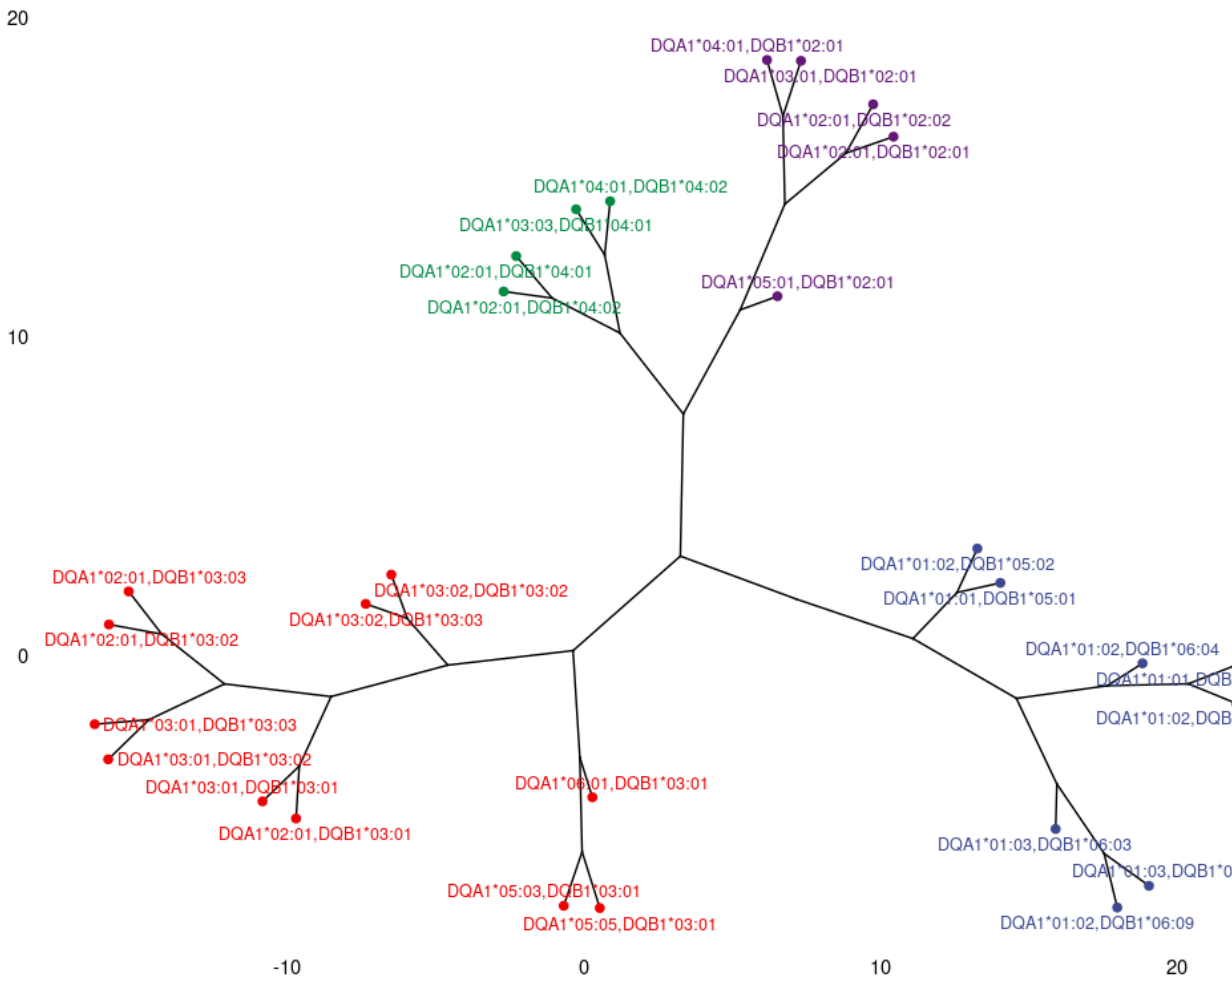
Figure 4. Dendrogram representing anti-HLA-DQ response correlations based on Minkowski dis- tances of antigen specific feature vectors. Three main branches corresponding to distinct groups of responses are observed. Responses against distinct β chains gather within a separate group, while responses against distinct α chains appear in all groups. Group A, in blue, includes responses against DQB1*05 and *06 as well as DQA1*01, group B (in green and purple) represents responses against DQB1*02 and *04, and group C (in red) includes responses against DQB1*03.